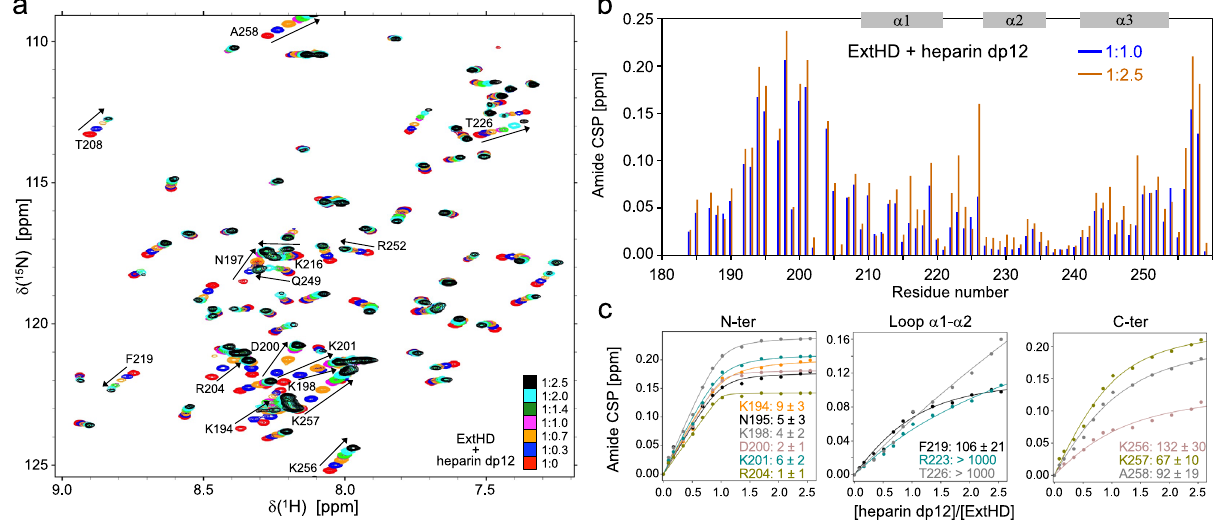
Fig. 3 | NMR characterization of ExtHD interaction with heparin dp12 at the amino acid level. Interaction of ExtHD with heparin dp12 is probed in 50mM NaH 2 PO 4 (pH 7.4) and 100mM NaCl. a Overlay of 1 H- 15 N HSQC spectra (500MHz) obtained for 15 N-ExtHD in the absence and presence of increasing amounts of heparin dp12. Stoichiometry between ExtHD and heparin dp12 is: 1:0 (red), 1:0.3 (dark blue), 1:0.7 (orange), 1:1 (pink), 1:1.4 (green), 1:2 (light blue) and 1:2.5 (black).